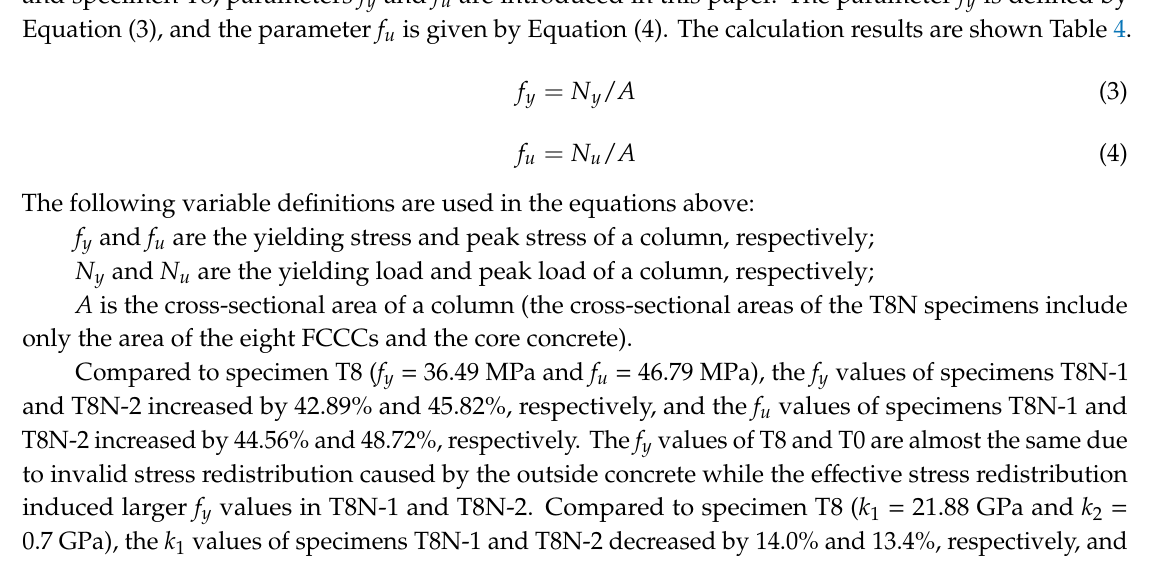
Table 4. Experimental and analytical results of the specimens.